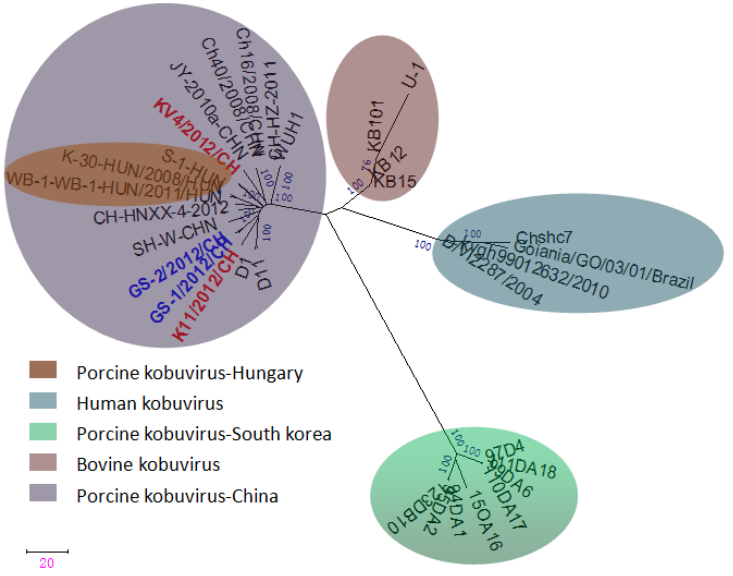
Figure 4. Phylogenetic tree of porcine kobuviruses based on the sequences from the 3D region (588 nt). The phylogenetic tree was constructed using the neighbor-joining clustering method; distance was calculated using the maximum composite likelihood correction for evolutionary rate in MEGA version 5.0. Bootstrap values (based on 1,000 replicates) for each node are provided when